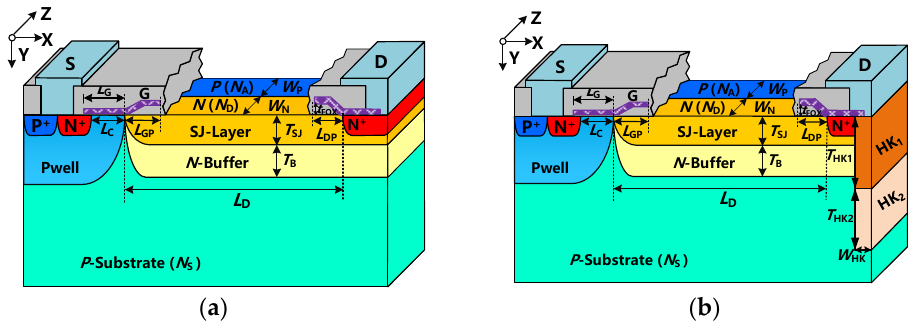
Figure 1. Three-dimensional view of ( a ) conventional SJ-LDMOS and ( b ) VHK SJ-LDMOS.